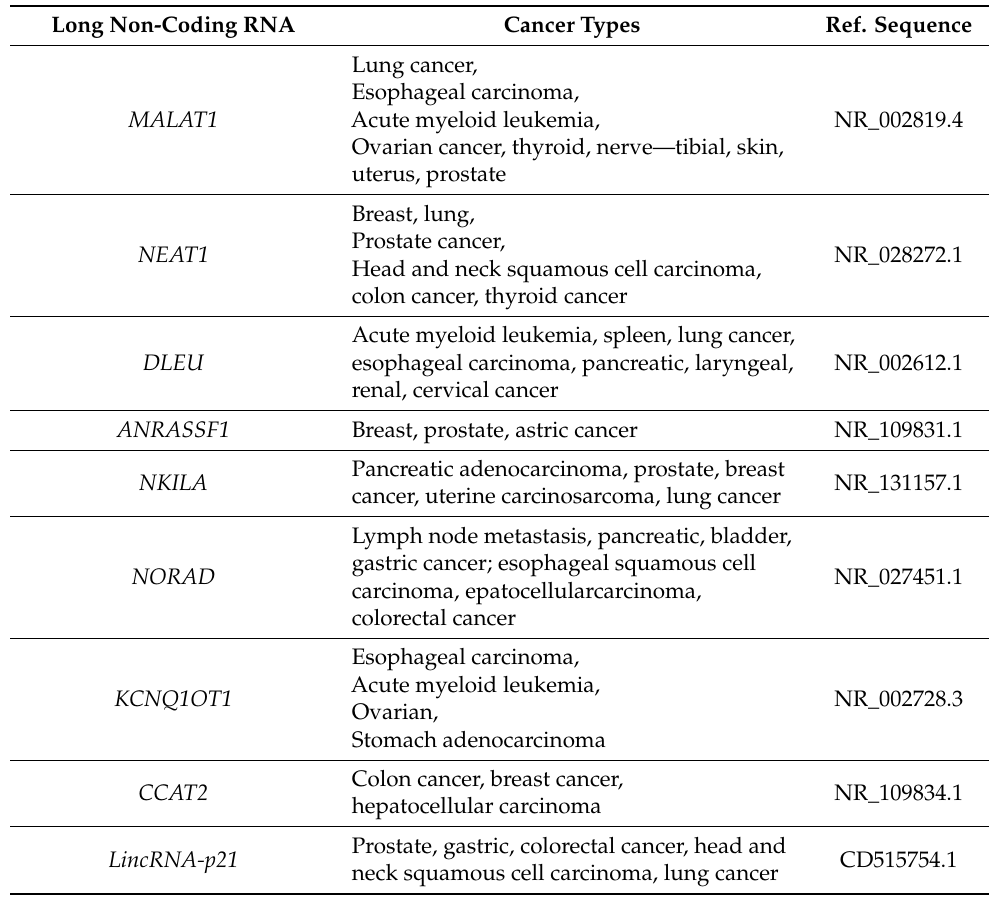
Table 1. Long non-coding RNAs which lack